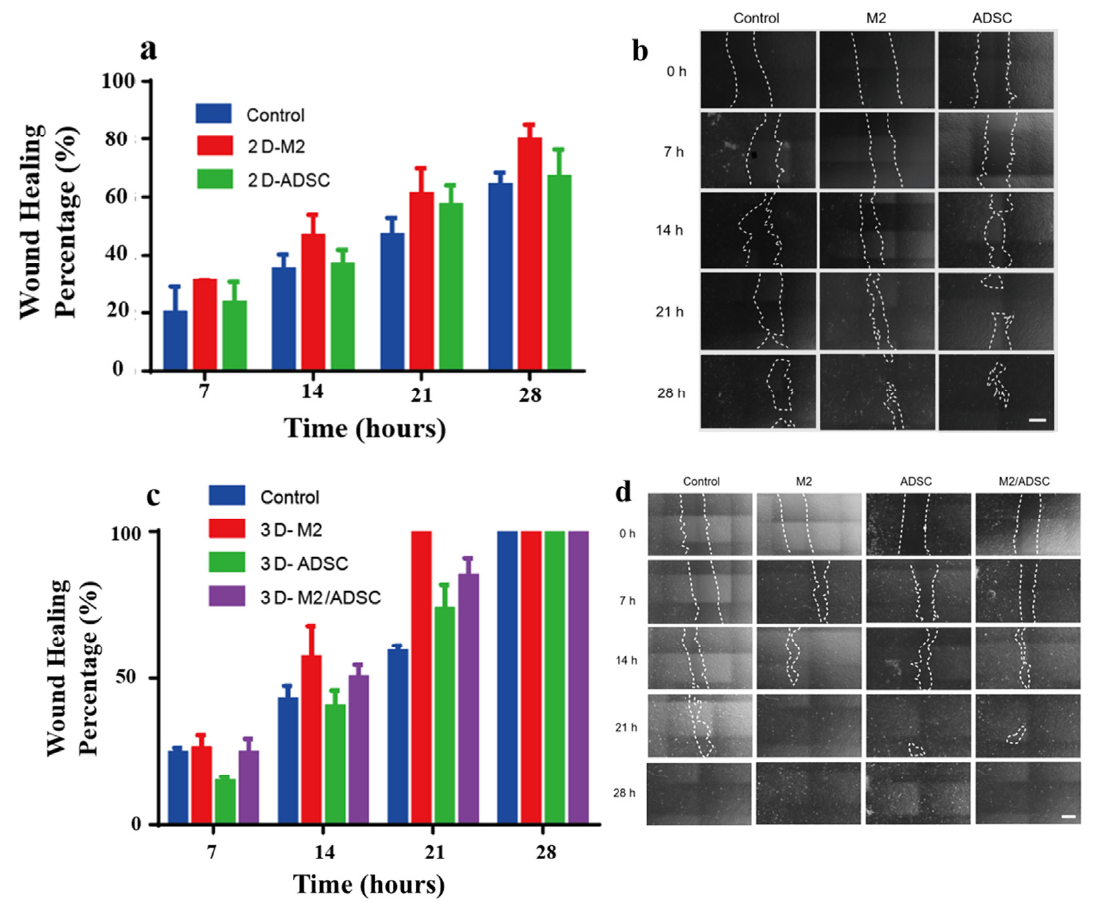
Figure 8. Wound healing percentage over time under the application of 2D and 3D paracrine systems in the in vitro model ( a , c ) and the corresponding HSF cell migrating photos ( b , d ).